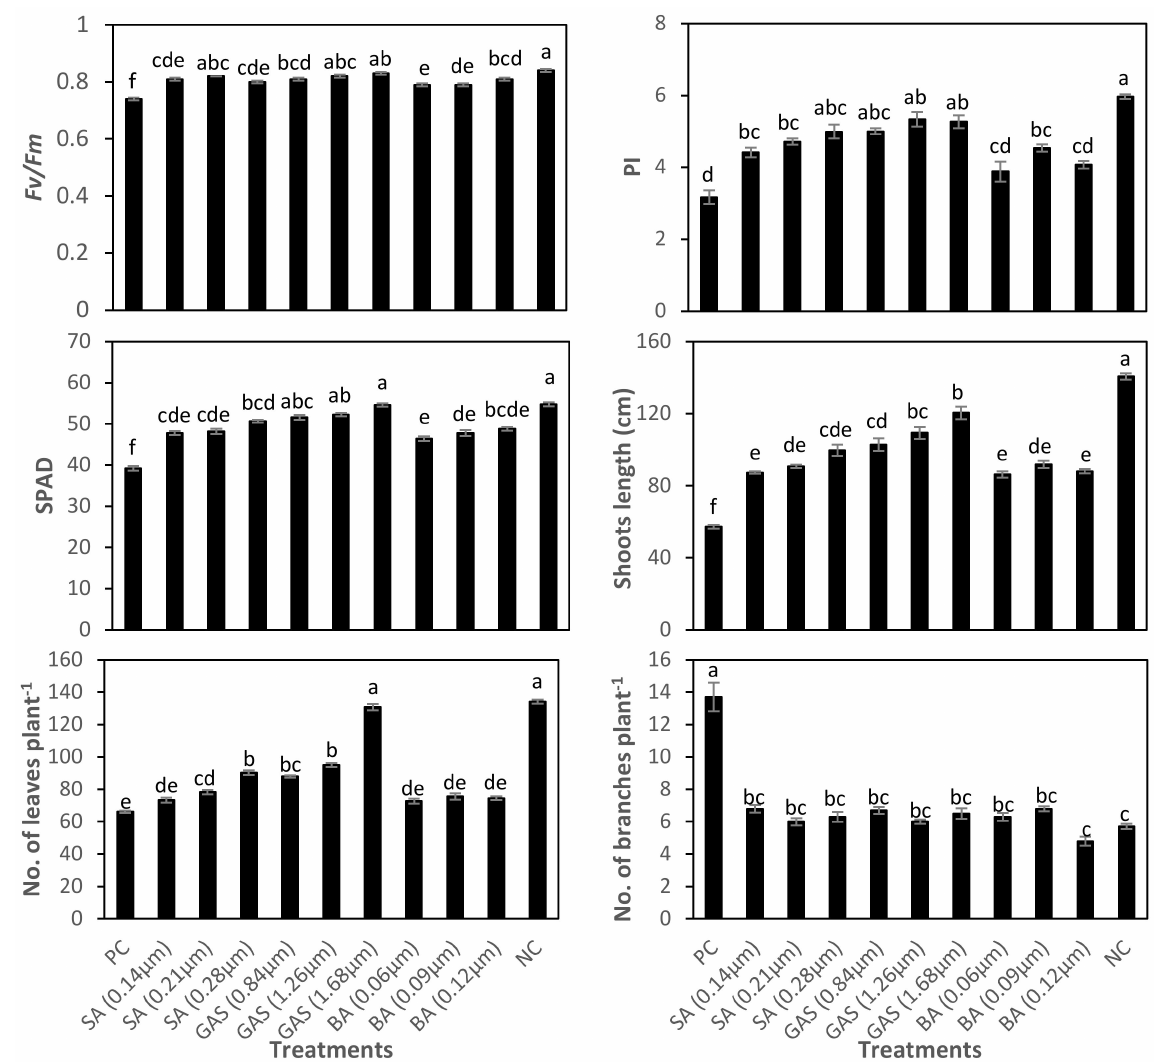
Figure 8. Variation in the photosynthetic efficiency ( F v / F m and PI), SPAD chlorophyll, shoots length, leaves number, and number of branches in negative control plants (NC), positive control plants (PC), and in response to foliage application of nano-salicylic acid (SA; 0.14, 0.21, and 0.28 µ M), nano-glycyrrhizic acid ammonium salt (GAS; 0.84, 1.26, and 1.68 µ M), and nano-boric acid (BA; 0.06, 0.09, and 0.12 µ M) to phytoplasma-infected faba bean plants. Means followed by the same letter in each column were not significantly different according to Duncan’s multiple range test ( p ≤